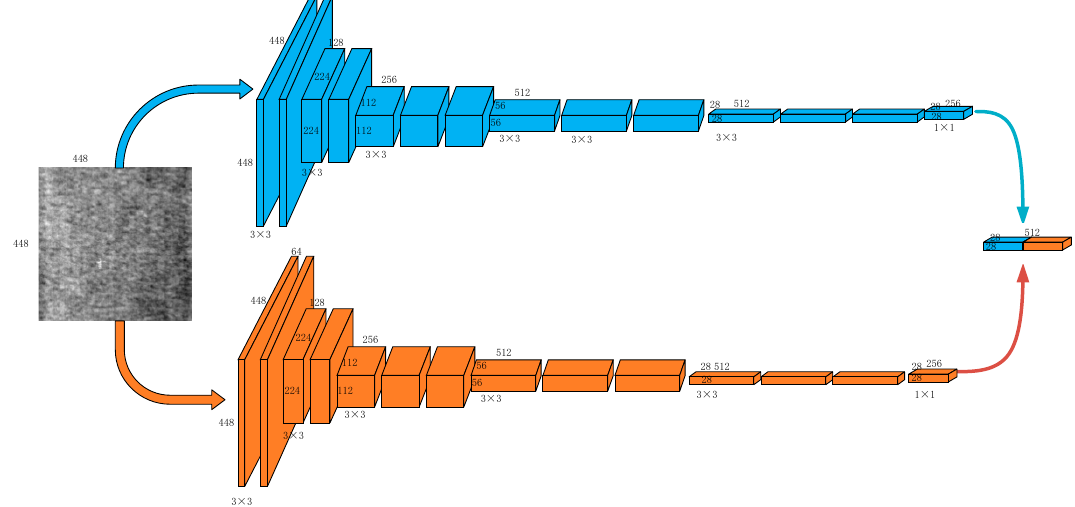
Figure 2. Double-Visual Geometry Group16 (D-VGG16) network structure. Feature maps with the same shape have the same width, height, number of channels and convolutional kernel.